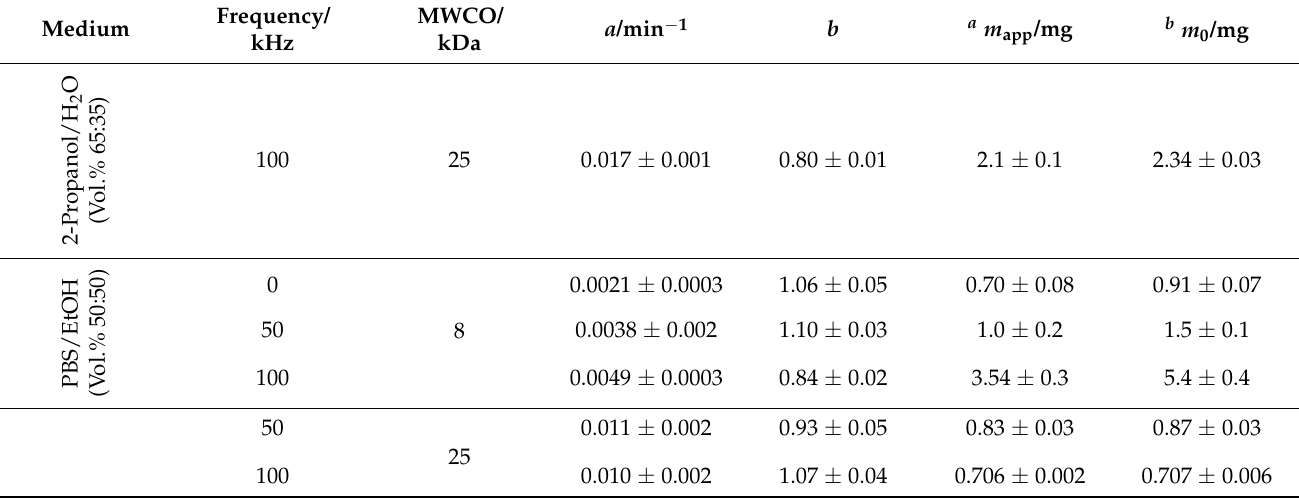
Figure 5. The cumulative mass of released quercetin through dialysis membranes with an MWCO of 25 kDa (left ordinate) at 37 ◦ C and the fraction of dialyzed quercetin relative to the total mass of quercetin in nanocarriers at t = 0 (right ordinate) under a magnetic field B = 11 mT and alternating field with frequencies of 0 kHz, 50 kHz, and 100 kHz in ( A ) PBS/EtOH (Vol.% 50:50) and ( B ) 2-propanol/H 2 O (Vol.% 65:35). Table 4. Parameters of the Weibull function describing the release kinetics of quercetin through a 25 kDa membrane without and under a permanent magnetic field B = 11 mT and alternating magnetic field at frequencies of 0 kHz, 50 kHz, and 100 kHz at 37 ◦ C in (A) PBS/EtOH (Vol.% 50:50) and (B) 2-propanol/H 2 O (Vol.% 65:35)